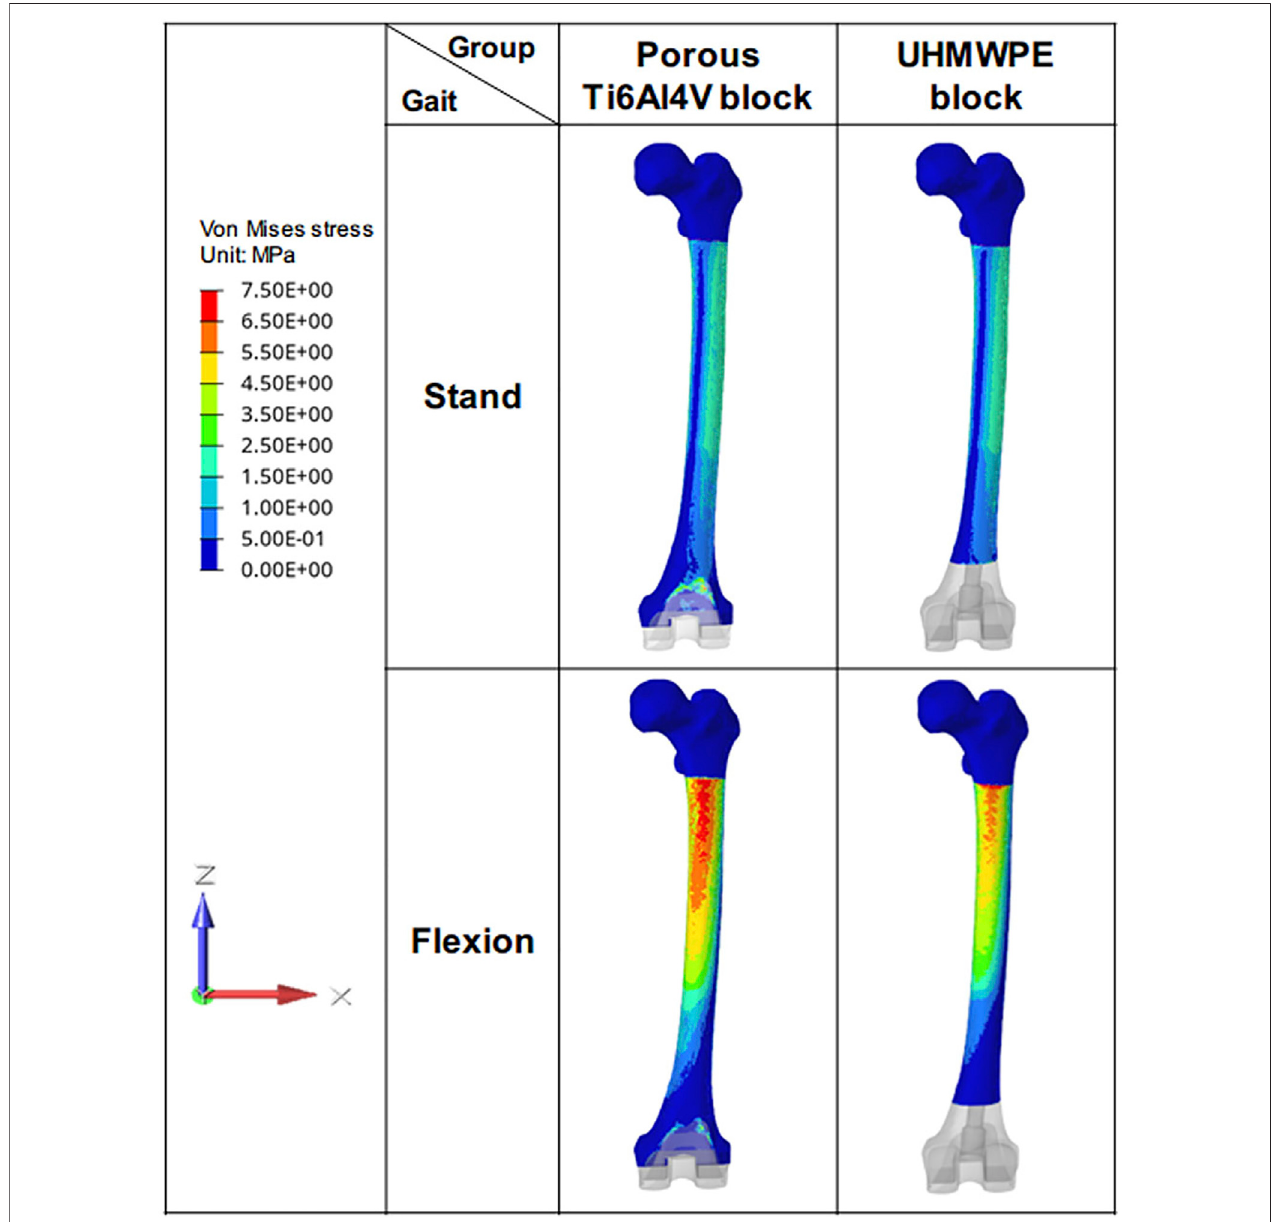
FIGURE 6 | Von Mises stress distribution of femur. The fi gure shows the stress distribution of femurs in different groups during the standing and fl exion stages.